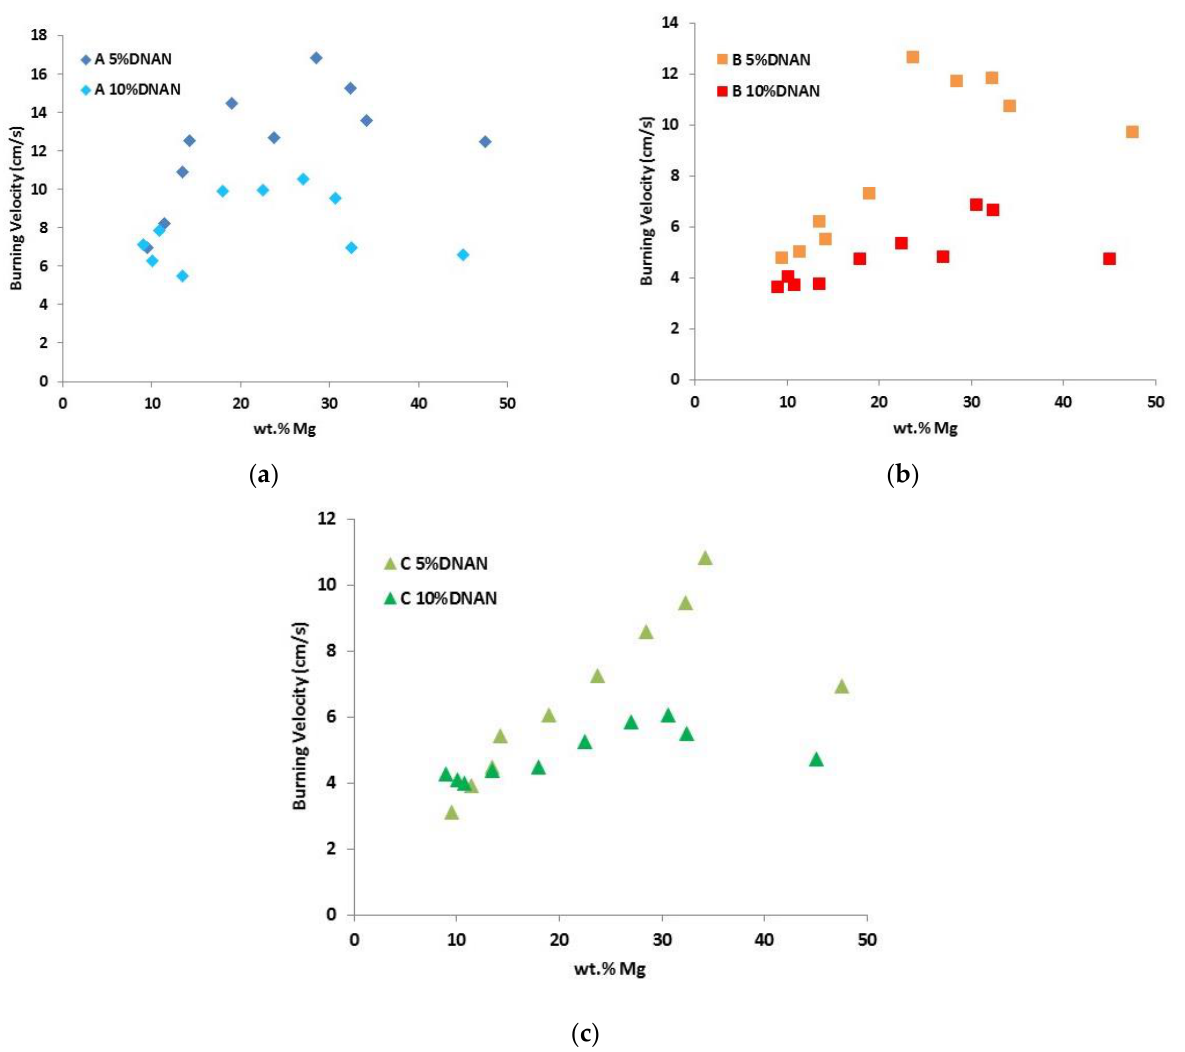
Figure 4. Measured burning velocities of ternary SrO 2 /Mg/DNAN compositions: ( a ) Compositions using Mg of class A; ( b ) Compositions using Mg of class B; ( c ) Compositions using Mg of class C. For each magnesium granulometric class, the stoichiometric compositions are X8 and sented in Equation (3).